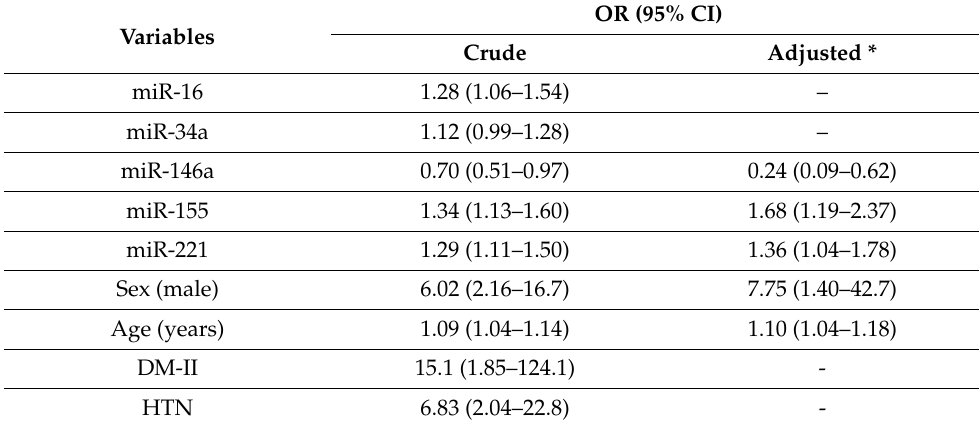
Table 2. Computed crude and adjusted odds ratios (OR) with 95% confidence intervals (CI) from logistic regression for the probability to identify severe COVID-19.